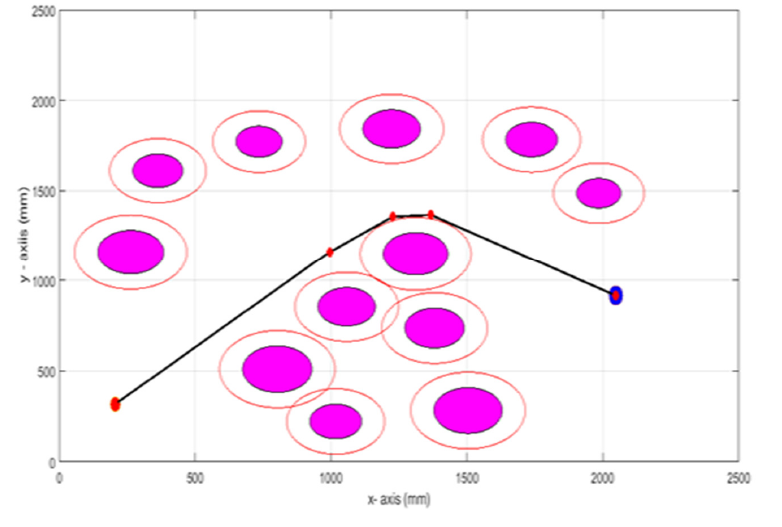
Fig. 10. Path Found by GWO Algorithm for Case 3.